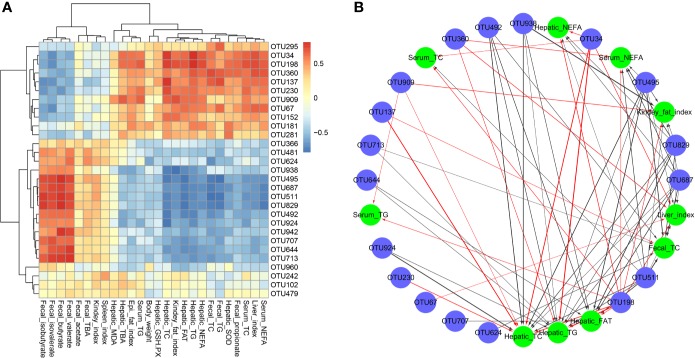
Spearman's correlations between the cecal microbiota and lipid metabolic parameters. (A) Heatmap of correlation coefficients and (B) visualization of the correlation network between the intestinal microbial phylotypes of significant differences and lipid metabolic parameters.